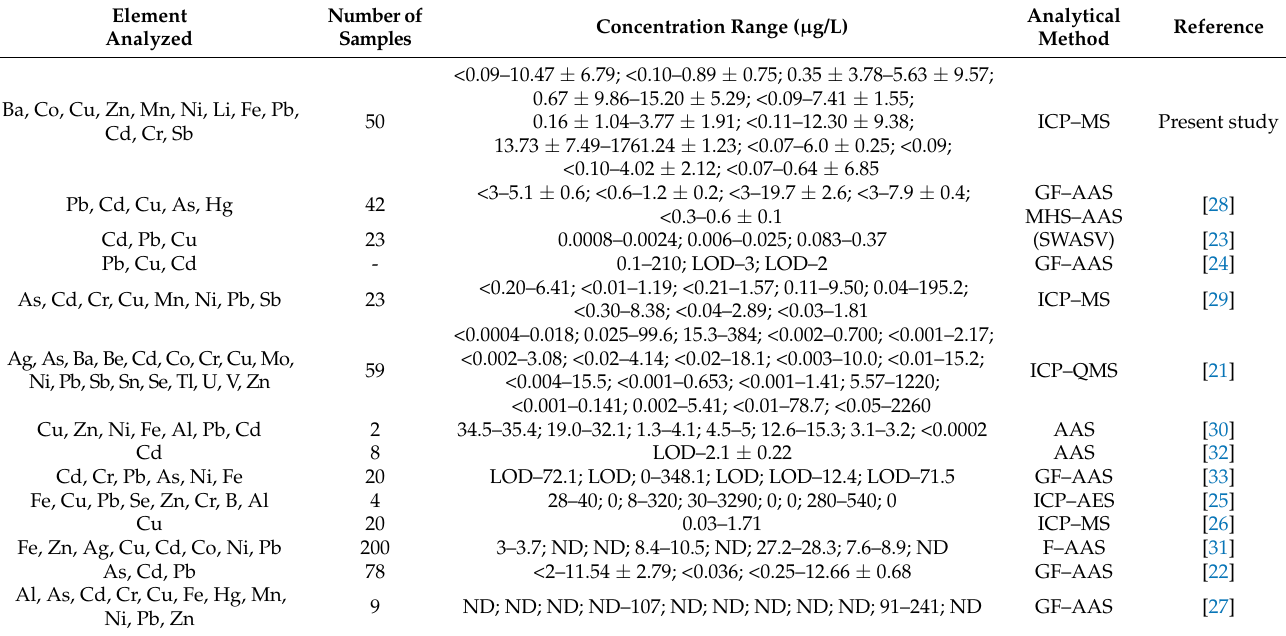
Table 2. Comparative study related to potentially toxic elements concentration in bottled drinking